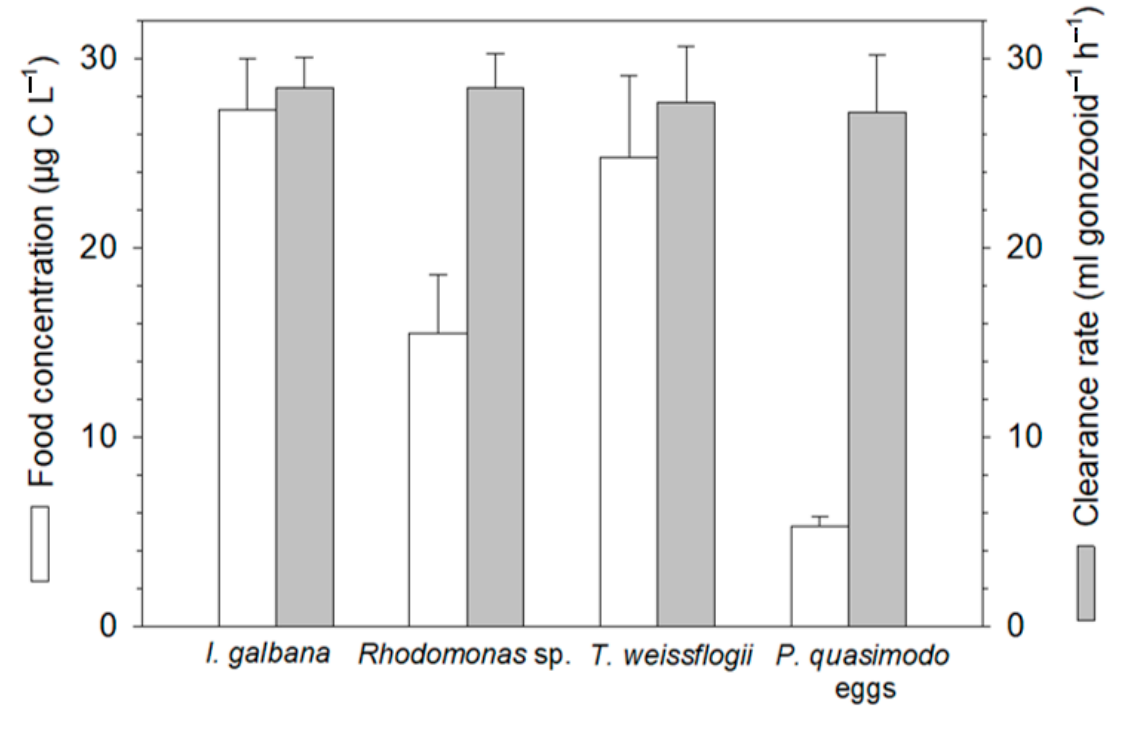
Figure 1. Dolioletta gegenbauri. Clearance rates of gonozooids of 6–7 mm length simultaneously offered eggs of Paracalanus quasimodo and cells of the three phytoplankton taxa ( Isochrysis galbana, Rhodomonas sp ., and Thalassiosira weissflogii ) at 20 °C.